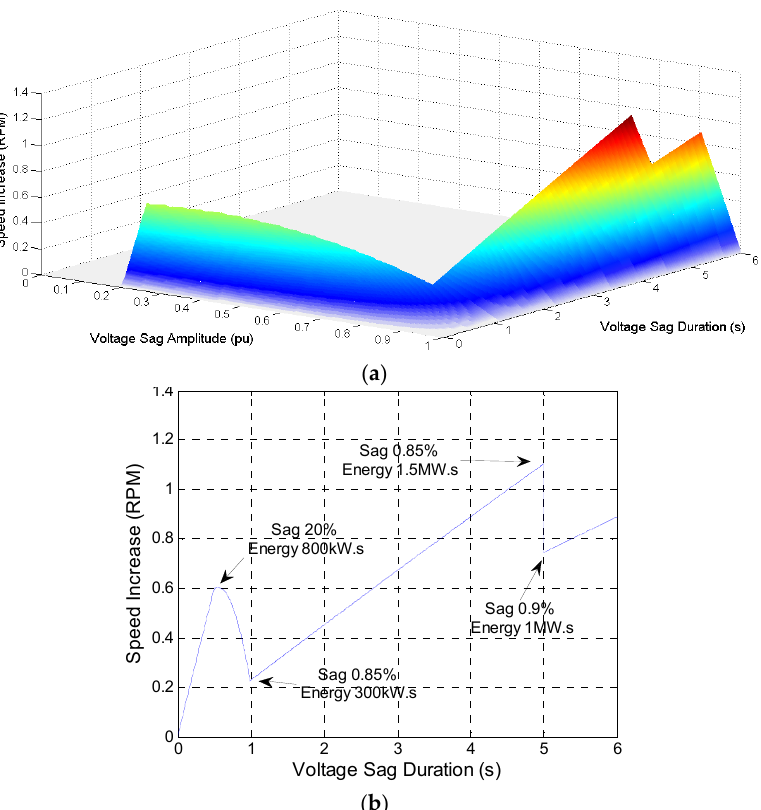
Figure 10. Speed increase for different voltage sags, considering the Brazilian RTFC curve and the 2 MW WECS: ( a ) speed as a function of voltage sag amplitude and duration and ( b ) maximum speed considering the worst conditions (maximum sag depth and duration).